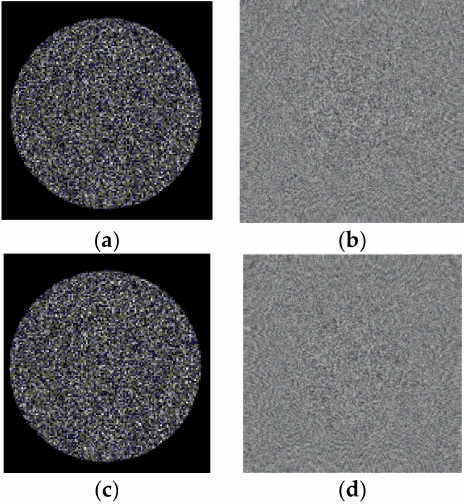
Figure 9. Reconstructed images before and after deformation. ( a ) Amplitude of reconstruction image ( t 1); ( b ) phase of reconstruction image ( t 1); ( c ) amplitude of reconstruction image ( t 2); ( d ) phase of reconstruction image ( t